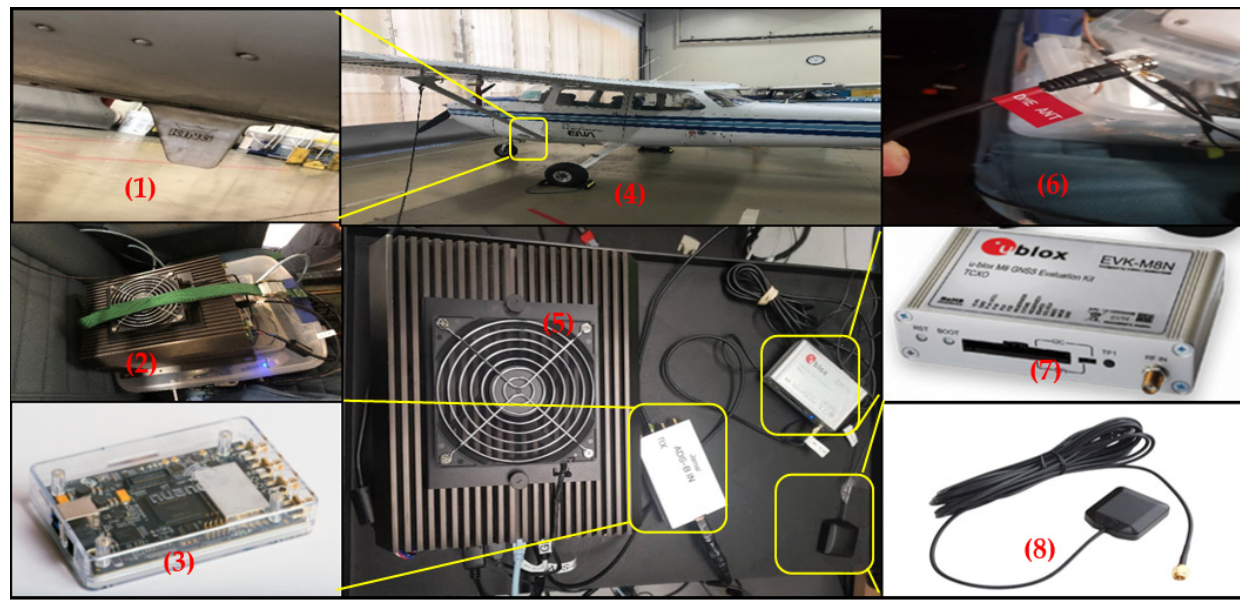
Figure 14. (1) Aircraft DME antenna; (2) Installed System inside Aircraft; (3) BladeRF V2 SDR; (4) Aircraft; (5) PC (Cincoze system; (6) Connector to DME antenna; (7) ublox(GPS); (8) ublox antenna;.